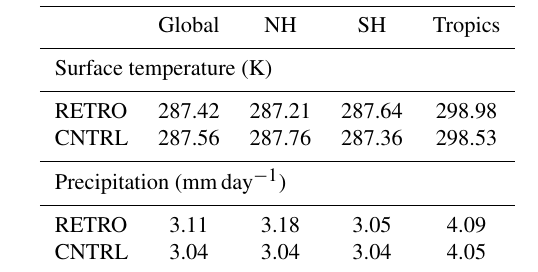
Table 1. Changes in precipitation and surface temperature. For these entries, the tropics are defined as between 22.3 ◦ S